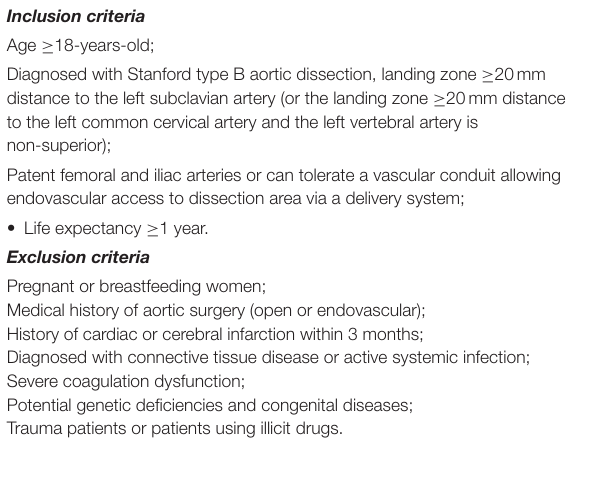
TABLE 1 | Anatomic and medical inclusion and exclusion